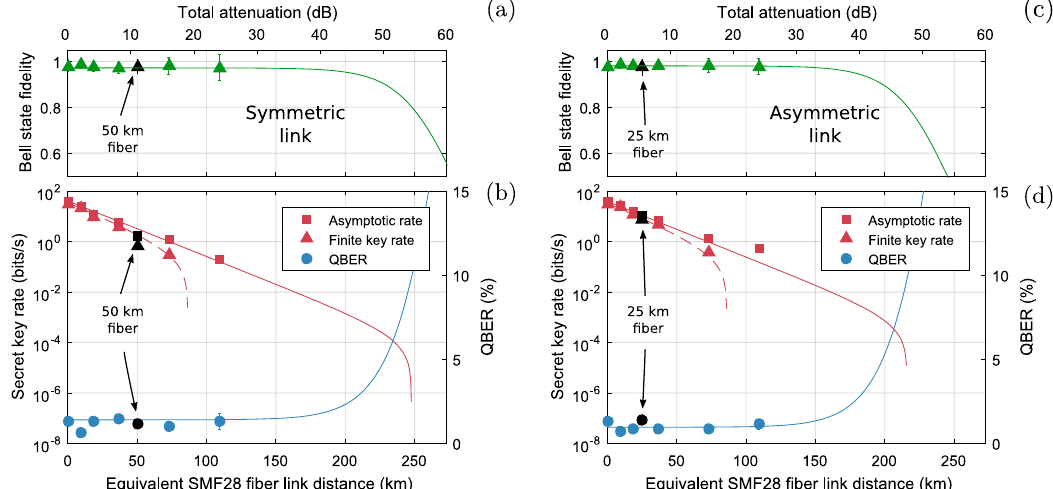
Fig. 4 Long-distance entanglement distribution and quantum key distribution. Lower bound to the fi delity to a Ψ þ j i Bell state, asymptotic and fi nite-size key rates and QBER for a ( a , b ) symmetric and an ( c , d ) asymmetric two-user link supported by 100 GHz ITU channels 23 (1558.98 nm) and 29 (1554.13 nm) as a function of SMF28 fi ber distance (lower x -axis) and attenuation (upper x -axis). Symbols represent experimental data and continuous lines theoretical predictions for a BBM92 scheme. Finite key rates are estimated assuming 10 min block